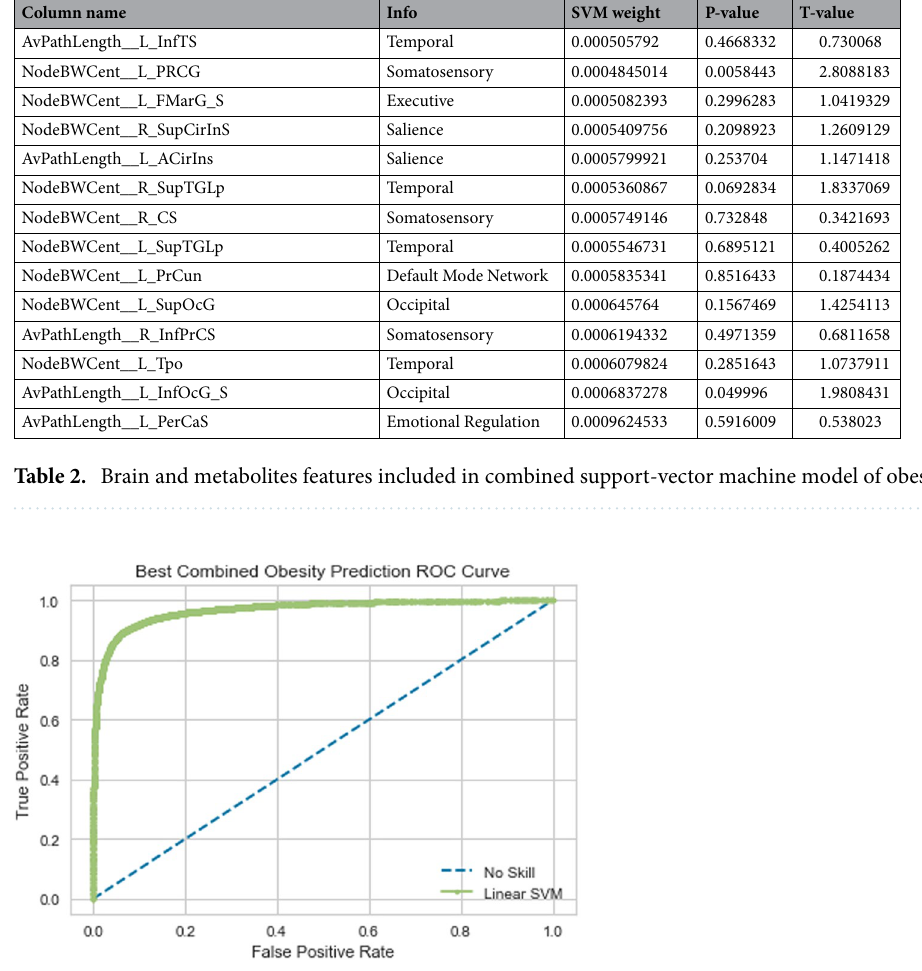
Figure 4. Receiver operating characteristic curve of support-vector machine model using combined brain and metabolite